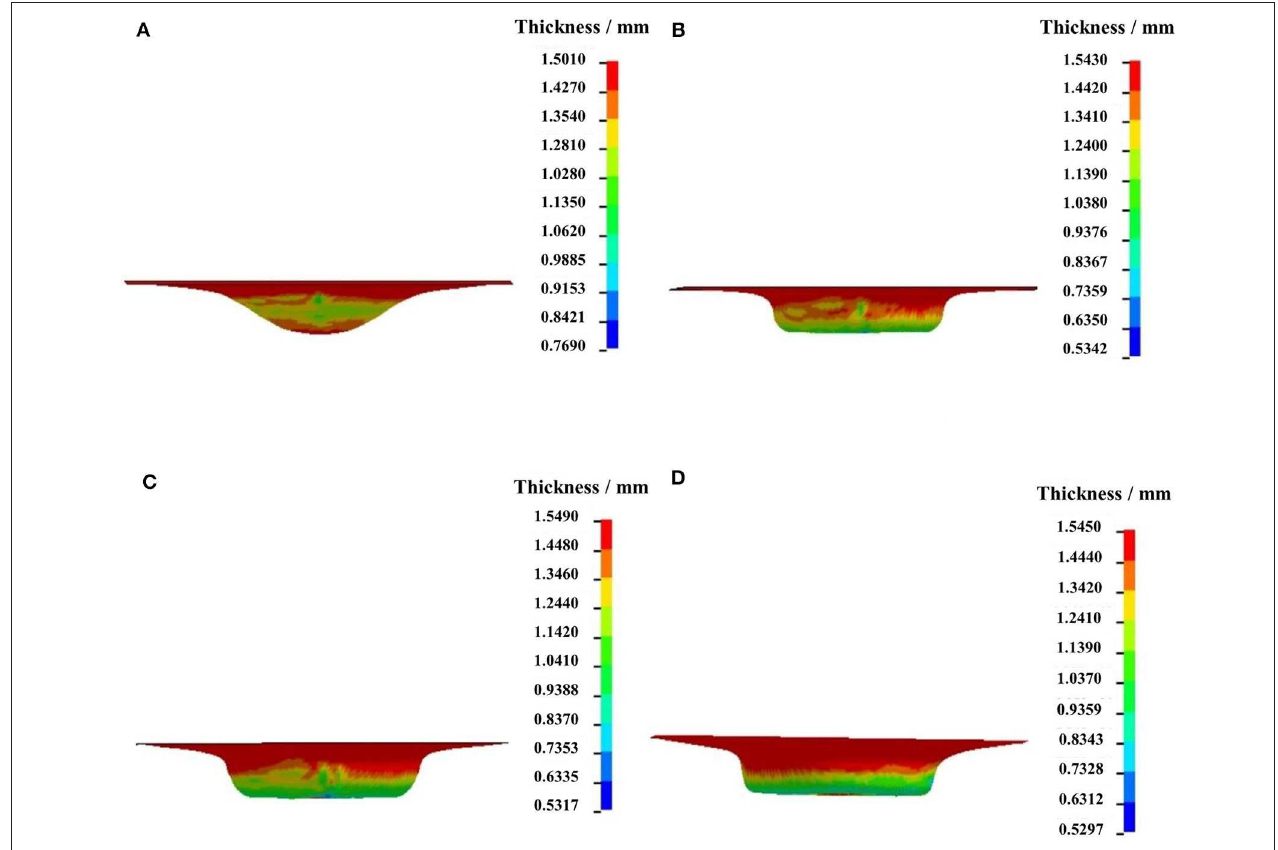
FIGURE 6 | Wall thickness contour of part in each of the four stages: (A) the first stage; (B) the second stage; (C) the third stage; (D) the fourth stage.